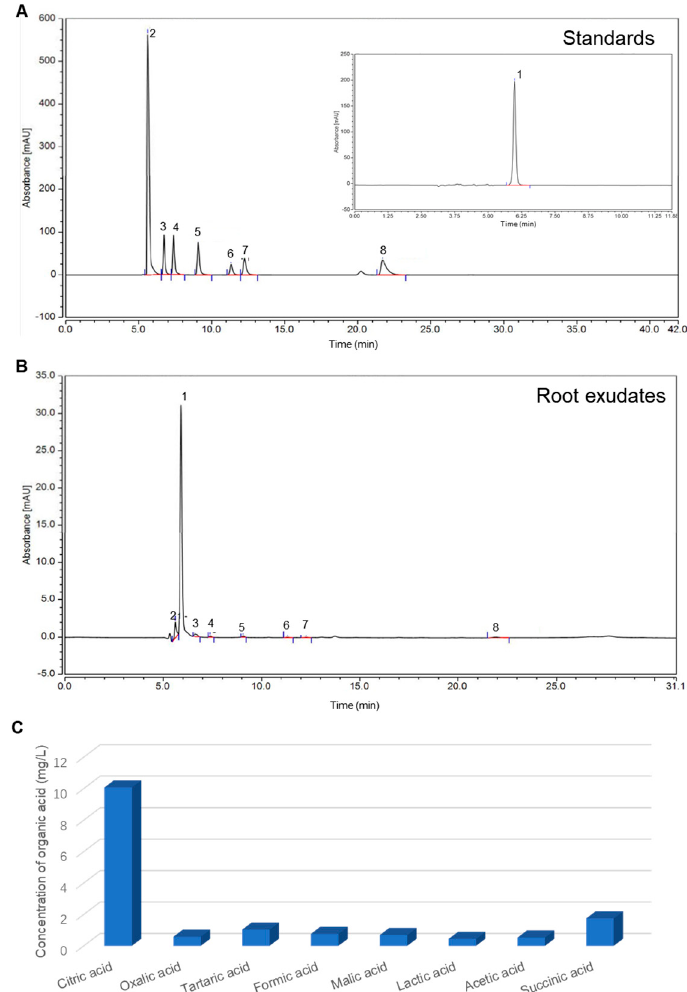
Figure 1. Chromatogram of organic acid standards ( A ) and root exudates ( B ) and concentrations of organic acids in the root exudates ( C ) detected by HPLC. The peaks are assigned to different organic acids: 1, citric acid; 2, oxalic acid; 3, tartaric acid; 4, formic acid; 5, malic acid; 6, lactic acid; 7, acetic acid; 8, succinic acid.